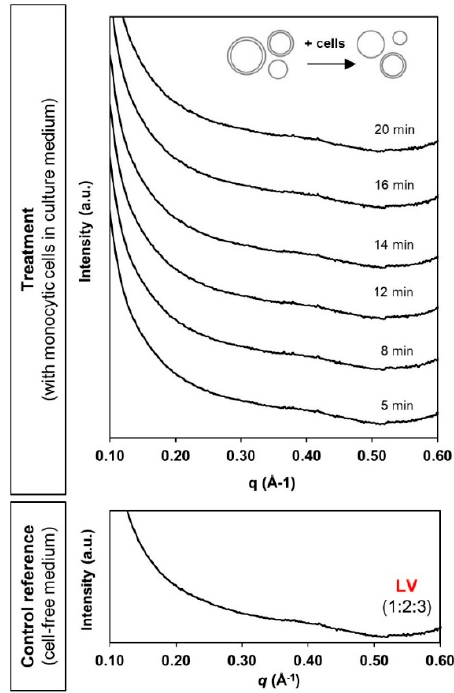
Figure 6. Bio-SAXS profiles of the phytantriol-based liposomes (LV) at 1 mg/mL lipid level under circulating flow conditions in the absence and presence of human monocytic cells (27 °C).